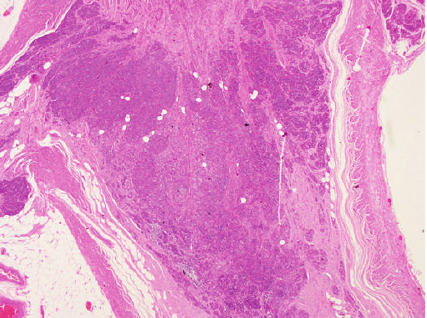
Figure 2: Low power microscopic view showing a normal ovarian tissue in the left side with a well-defined leiomyoma in the right side of the picture (H&E).